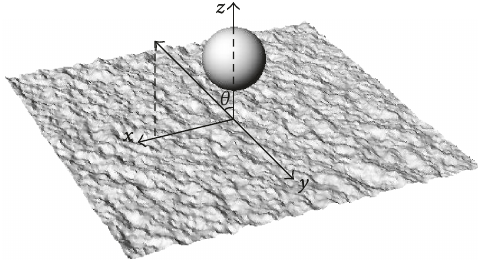
Figure 11: Illustration of a sphere on flat plate.